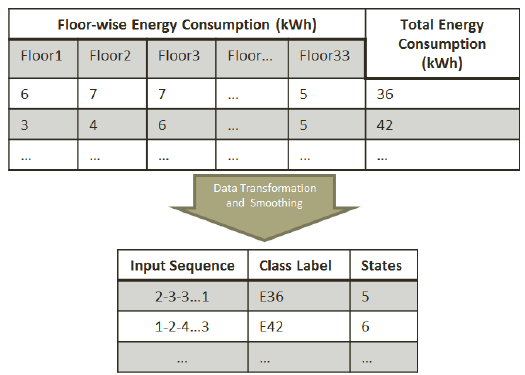
Figure 9. Illustration of data transformation-sample data (per hour energy consumption) to occupancy sequence with corresponding class and state